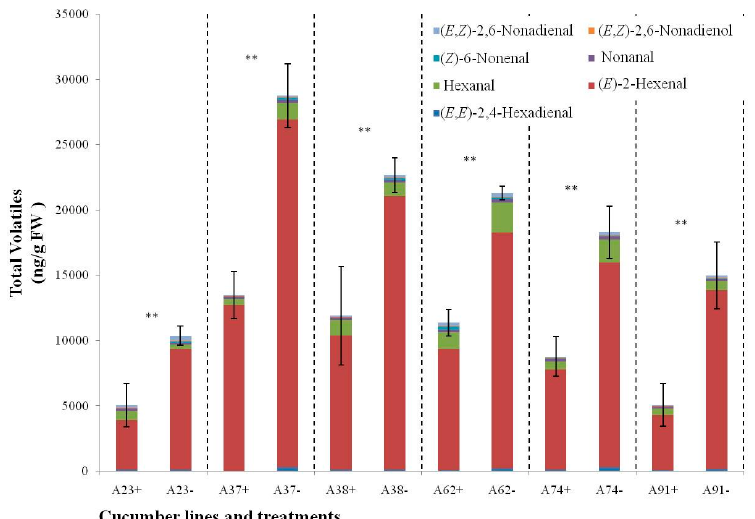
Figure 7. Changes in content of short-chain volatiles in six inbred cucumber leaves at 5 day after N-deficient treatments. Bars present means ± standard deviations. + and − mean N-sufficient and deficient treatments, respectively. ** mean significant difference from control at p < 0.01. Values are means of three biological replicates.